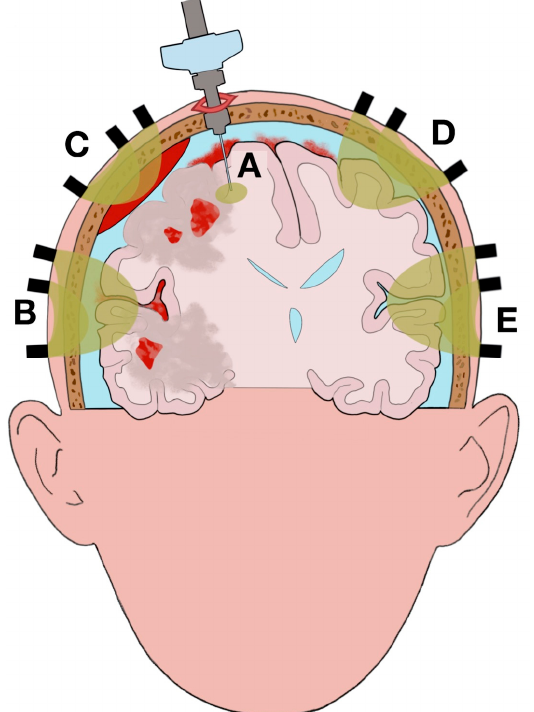
Figure 1. Illustration of the complexity of the pathophysiological elements related to brain trauma on the different areas scanned (highlighted in yellow) by partial oxygen pressure (PbtO 2 ) and near-infrared spectroscopy (NIRS) neuromonitoring. The figure illustrates a possible clinical scenario in traumatic brain injury (TBI): epidural hematoma, subarachnoid hemorrhage, brain edema, and multiple contusions with perilesional tissue (penumbra of brain edema) on the right hemisphere causing midline shift and compression of the right lateral and third ventricles. ( A ): area scanned by intracranial PbtO 2 monitor. The area scanned is mainly without anatomical lesions; however, a small portion is included in perilesional tissue. The heterogeneity of the brain status across the scanned area can influence the values recorded and mislead clinicians. ( B ): NIRS recording (with overlapping channels at different source-detector (SD) distances) of brain edema and subarachnoid hemorrhage. The lesions are not fully scanned because of the limited depth of the optical assessment. ( C ): NIRS recording of epidural hemorrhage. Significant light absorption by the epidural hemorrhage reduces the depth of the optical assessment and makes it impossible to monitor the brain edema and the contusions underneath. ( D ), ( E ): NIRS recording of spared tissue (normal tissue respiration). The comparison between channels B, C, D and E allows clinicians to identify the side of the lesions between hemispheres.